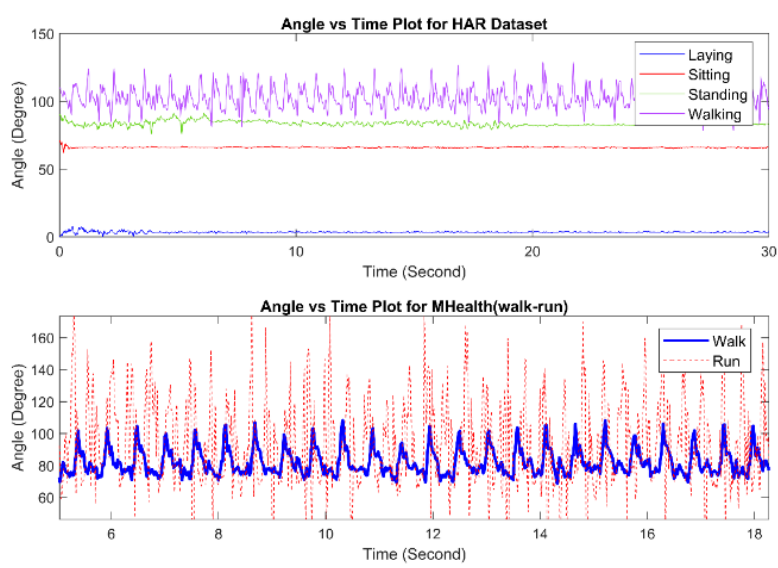
Figure 5. Plots of angle between acceleration vector and gravity. The up panel denotes the laying, sitting, standing, and walking angle for the Human Activity Recognition (HAR) dataset and the down panel walking and running angle for the MHealth dataset.